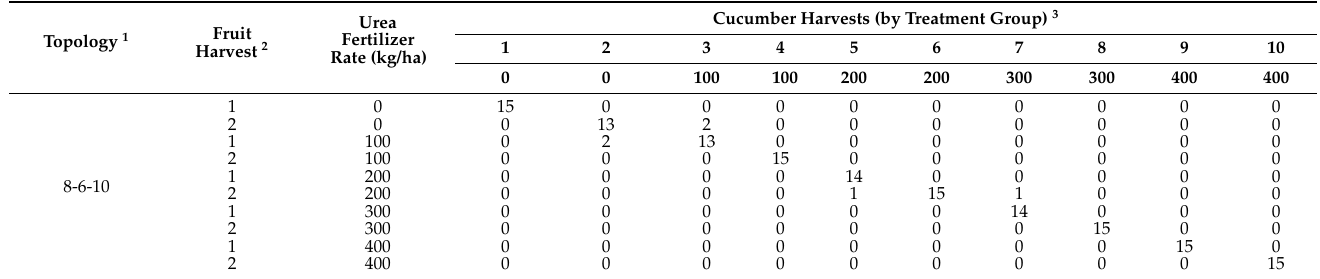
Table 7. Confusion matrix for the 10 cucumber treatment groups (based on the urea fertilizer applied) using the ANN classification